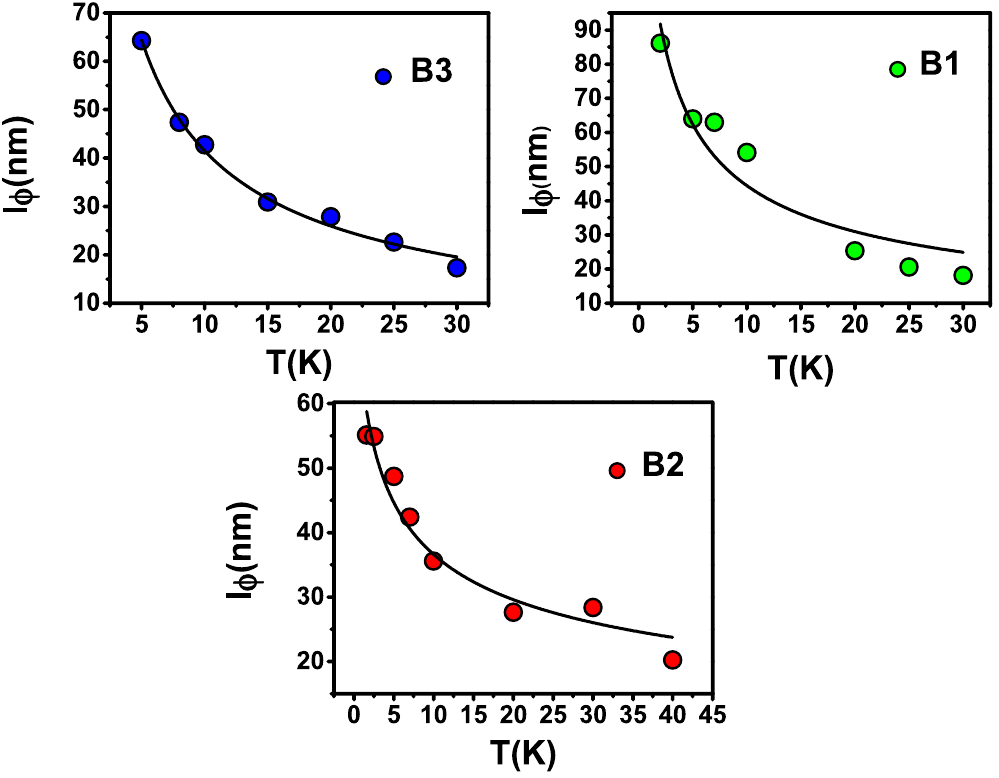
Figure 6. Phase coherence length vs. temperature for the three thin films B3, B2 and B1. The variation with temperature follows the expected power law behavior with ϕ l ~T − p